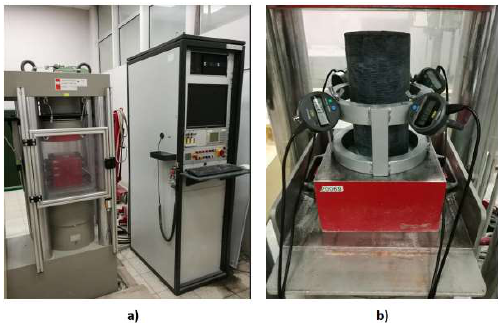
Figure 2. Compressive testing machine Walter + Bai AG ( a ) and localization of transverse strain gauges ( b